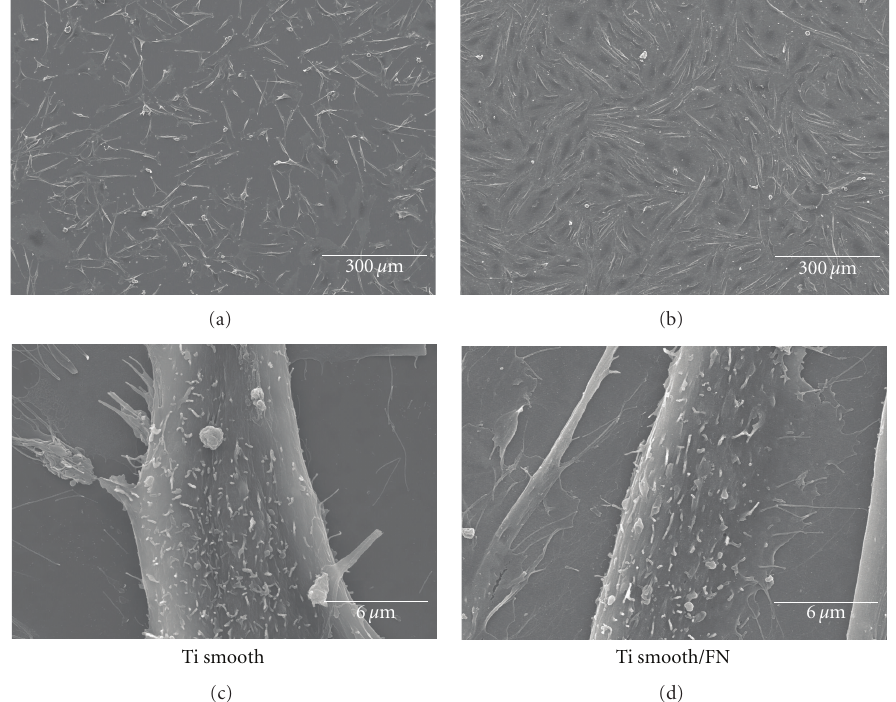
Figure 4: SEM views of MC3T3-E1 cells cultured on Ti smooth and Ti smooth/FN titanium disk at 1 day of culture. Ti sand, no significant di ff erences were detected between Ti smooth/FN and Ti smooth. Between 1 day and 11 days of cell culture, there were no significant di ff erences for each titanium